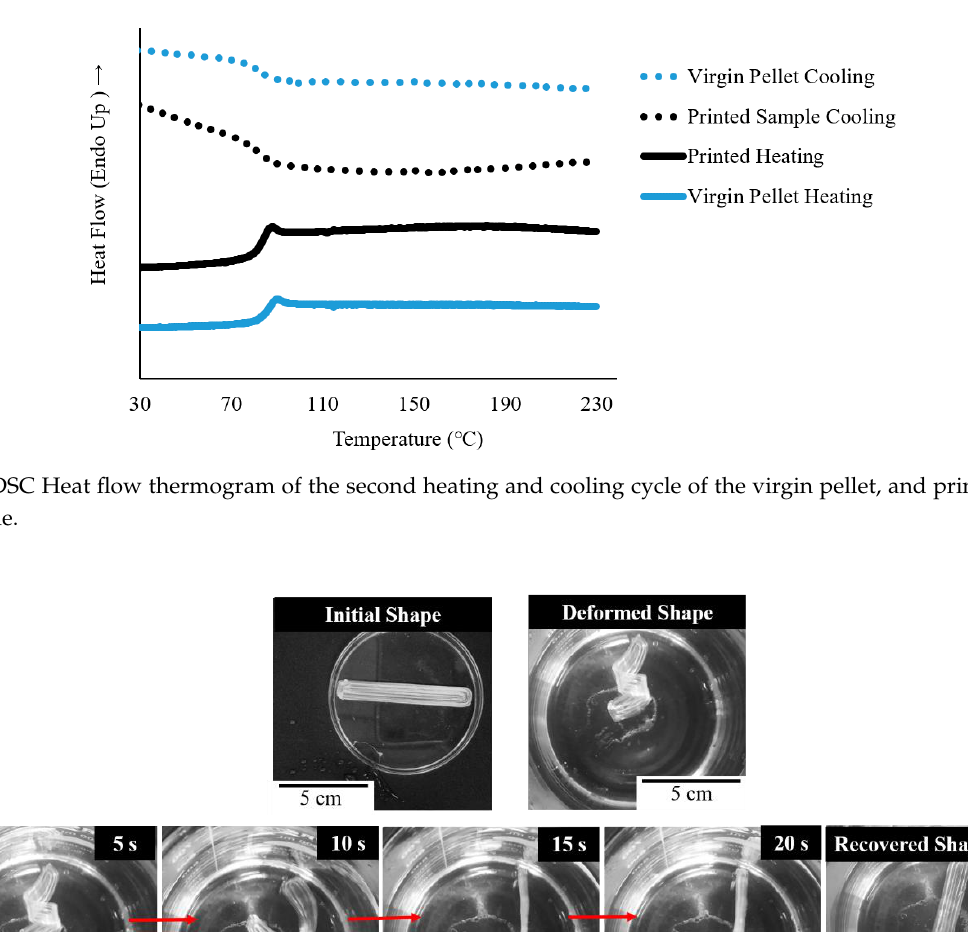
Figure 6. The shape recovery of a flat bar in hot water.